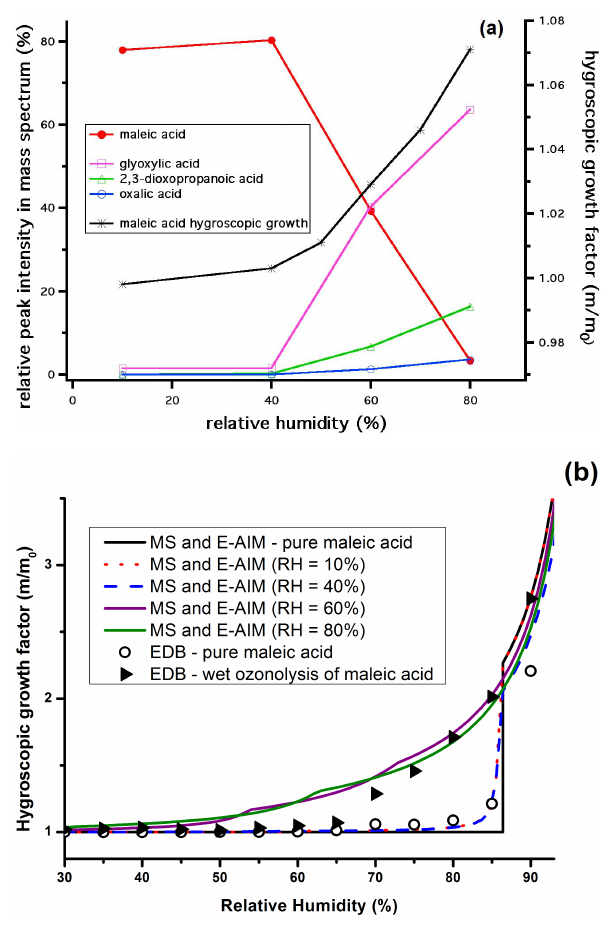
Fig. 4. (a) Relative peak intensities of maleic acid and three oxi- dation products are shown as a function of relative humidity (left y-axis) as well as the hygroscopic growth factor of pure maleic acid as a function of humidity (right y-axis). Below 50% RH negligible hygroscopic growth occurs and the yield of oxidation products is very low. Above 50% RH water associated with the aerosol leads to an increased yield of oxidation products demonstrating the close link of hygroscopicity and chemical composition. (b) Measured and modelled mass growth humidograms for pure maleic acid aerosol and of maleic acid under wet ozonolysis conditions. The predicted growth curves use the mass spectrometry data to estimate aerosol composition and hence hygroscopicity. All data is for the deliques- cence growth mode. Black line – predicted growth curve for pure maleic acid. Red dotted line – predicted growth curve for maleic acid aerosol ozonolysed at 10% RH. Blue dashed line – predicted growth curve for maleic acid ozonolysed at 40% RH. Purple line – predicted growth curve for maleic acid ozonolysed at 60% RH. Green line – predicted growth curve for maleic acid ozonolysed at 80% RH. Open circles – measured growth curve for pure maleic acid. Closed triangles – measured growth curve for maleic acid aerosol which had been ozonolysed in its deliquesced